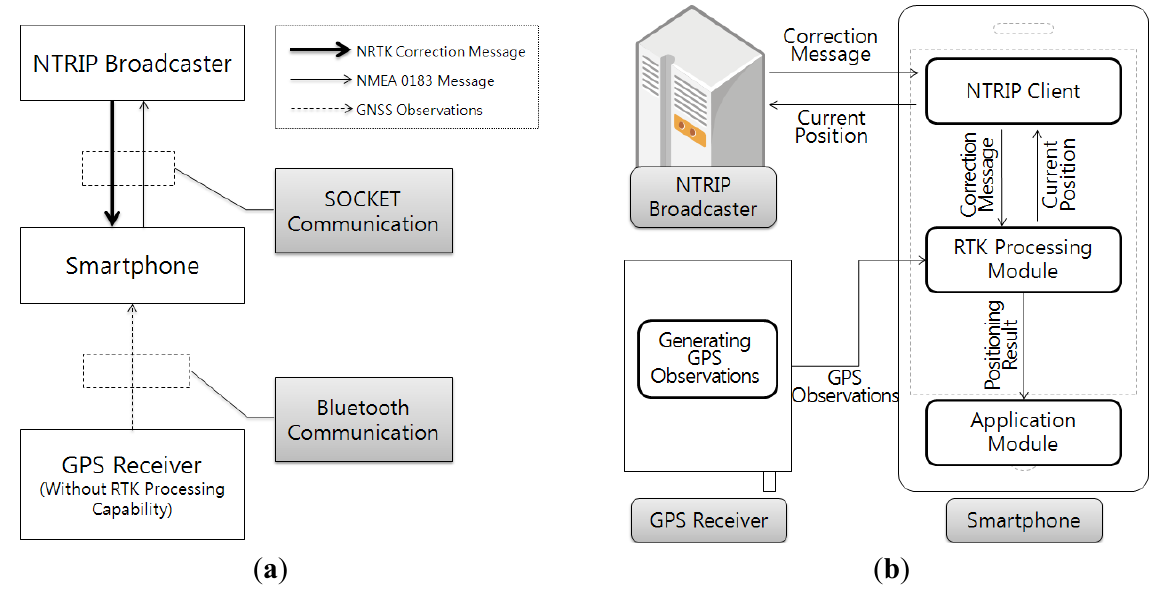
Figure 1. Design of the NRTK application for smartphones when use the general GPS receiver without the RTK function. ( a ) Communication method and data flow. (b ) Composition of NRTK application and data flow.